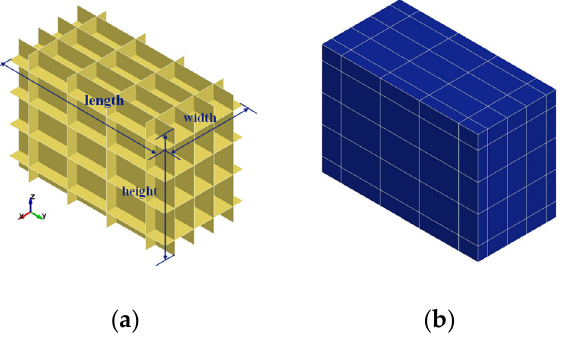
Figure 2. Finite element model. ( a ) Box structure and coordinate system; ( b ) Air domain.